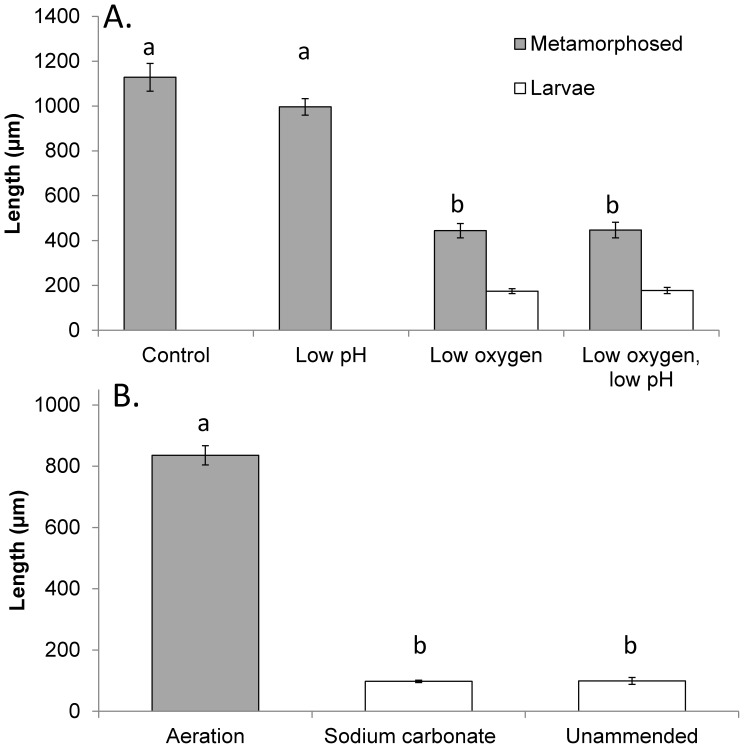
Size of early life stage A. irradians larvae, grown under two levels of pH and dissolved oxygen.
A. Experiment with mixing gases, and B. Experiment manipulating naturally low oxygen and low pH water with aeration and sodium carbonate Bars are means ±S.D. Complete carbonate chemistry from experiments appear in Tables S1 and S2 while statistical analyses appear in Tables S7 and S10. Shared lower case letters indicate treatments that are not significantly different (p>0.05). Statistical comparisons were among metamorphosed individuals only in panel A, but was between individuals of the same cohort that were metamorphosed individuals in the aerated treatment and larvae in other treatments in panel B as no individuals had metamorphosed in those treatments.